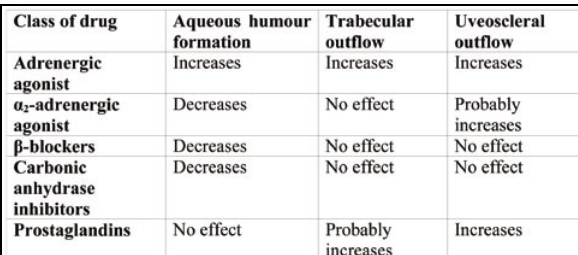
Table 1: Site of action of the different classes of durgs used in the treatment of glaucoma